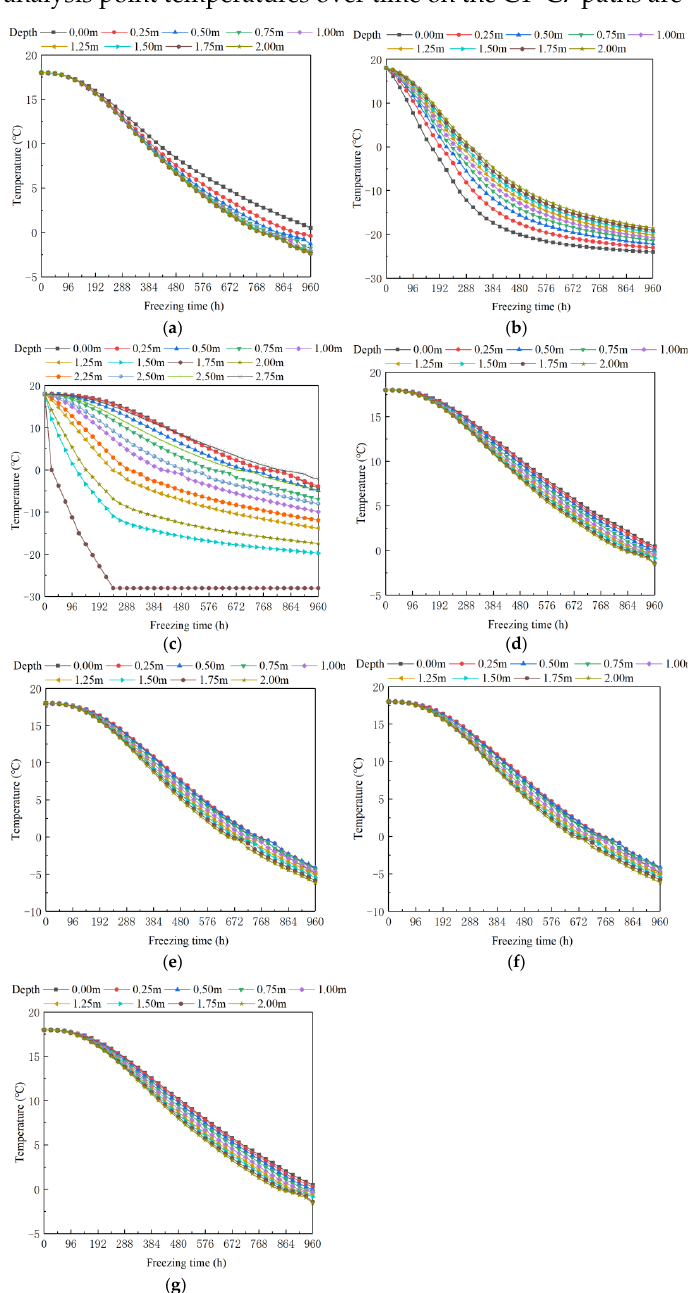
Figure 8. Temperature changes at points C1 – C7 against freezing time. ( a ) C1 path, ( b ) C2 path, ( c ) C3 path, ( d ) C4 path, ( e ) C5 path, ( f ) C6 path, ( g ) C7 path.